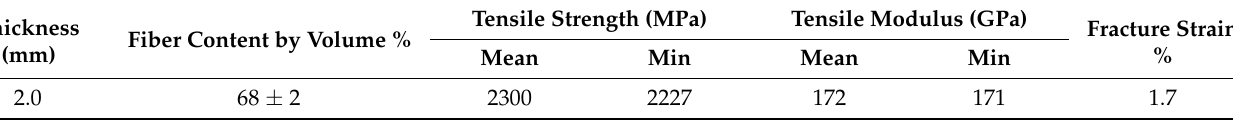
Table 2. Properties of unidirectional CFRP plate specimens at room temperature.